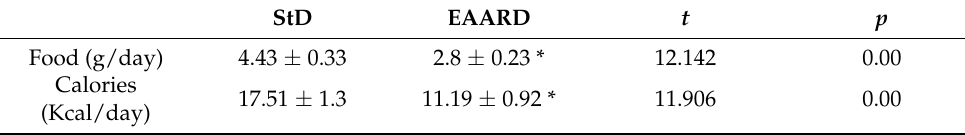
Table 2. Mean daily food and caloric intake (mean ± sd) according to diets.